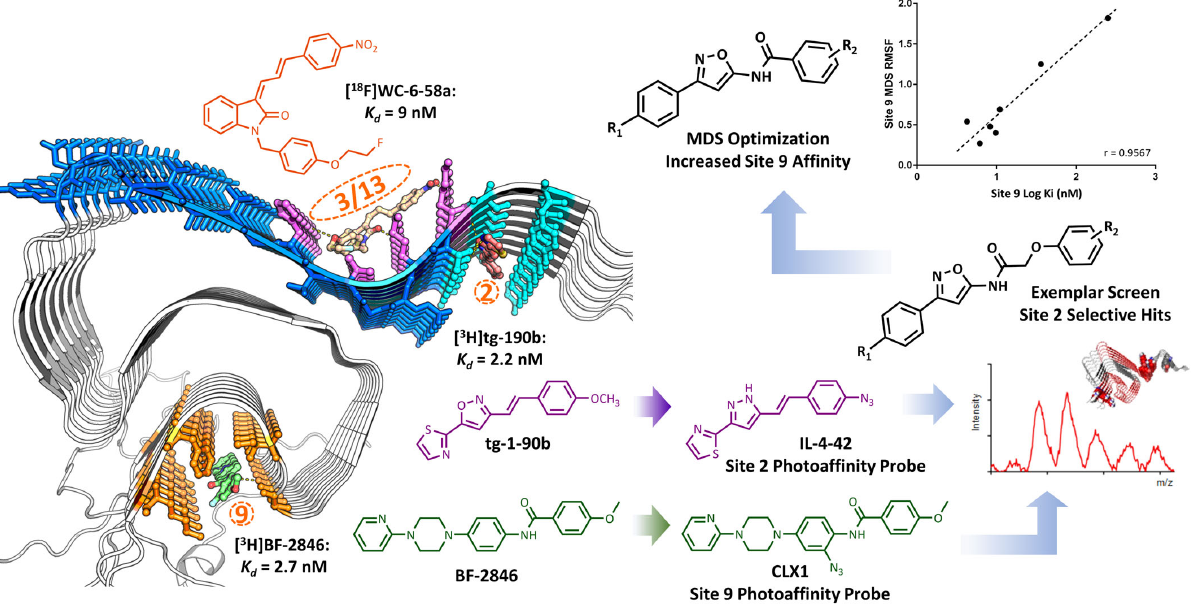
Figure 6. Three putative alpha-synuclein binding sites, Sites 2, 3/13, and 9, identified from the blind docking studies. Site 2 and Site 9 were confirmed via in vitro photo-cross-linking and mass spectrometry studies. [ 3 H]tg-190b and IL-4-42 are the radioligand and photoaffinity probes for Site 2. [ 3 H]BF-2846 and CLX1 are the radioligand and photoaffinity probes for Site 9. Site 2 and Site 9 probes were used to test in silico hits from the Exemplar screen and Site 9 optimization based on MDS.